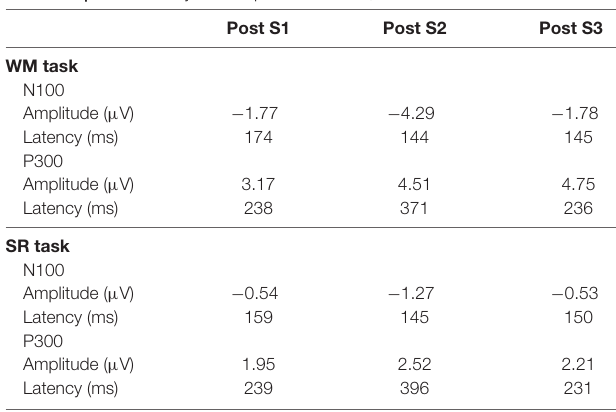
TABLE 1 | Peak latency and amplitude of N100, and P300 in